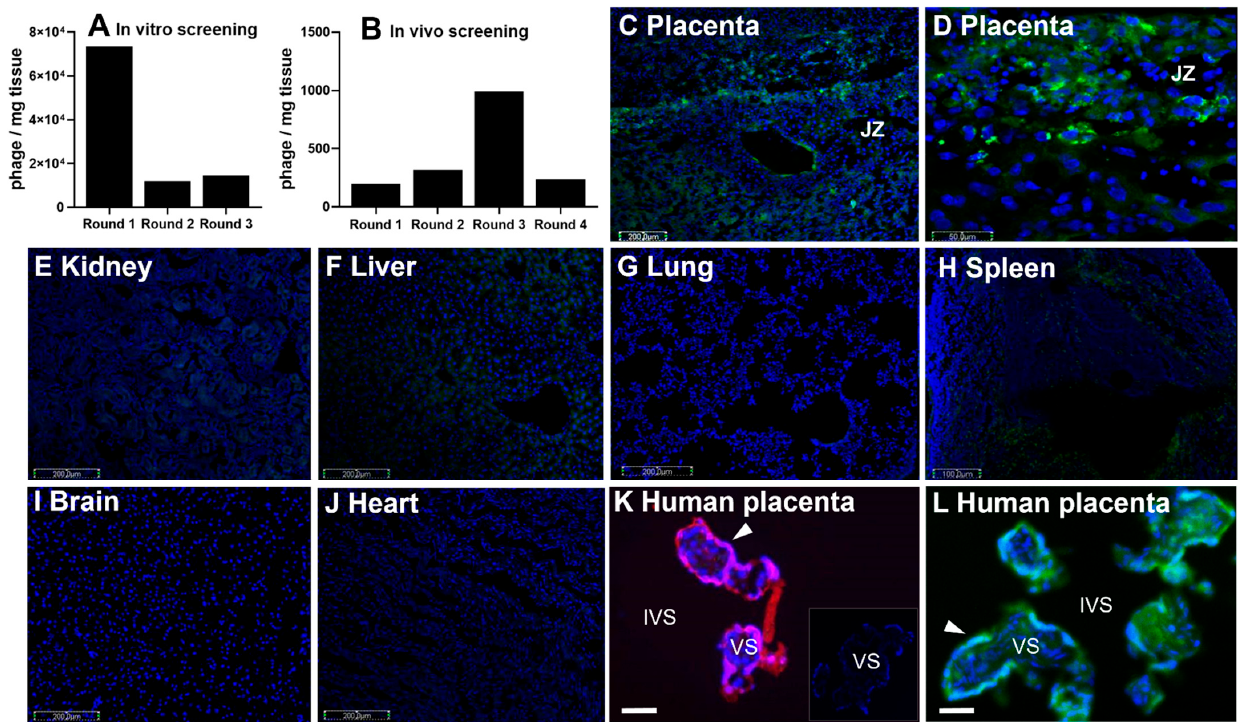
Figure 1. Identification and localization of placental-homing peptide CGPSARAPC (GPS). ( A ) Mouse placental tissue was incubated with a T7 bacteriophage CX7C library and bound phages were tittered, amplified and purified. Phage titer (pfu/mg tissue) was measured using a plaque-forming assay (median ± SEM; n = 3). ( B ) After 3 rounds of ex vivo selection, the resulting phage pool was injected into the tail vein of a pregnant mouse. Placentas were harvested and bound phage pools were tittered, amplified and purified. Four rounds of in vivo screening were performed, and phage titer is expressed as pfu/mg tissue (median ± SEM; n = 3). ( C – J ) CCGPSARAPC labeled with 5(6)-carboxyfluorescein (CFS; 200 µg) was injected into the tail vein of pregnant mice ( n = 4; E0.5 – E17.5). Following cardiac perfusion to remove unbound peptide, placentas ( C , D ) and maternal organs ( E – J ) were harvested and assessed by fluorescence microscopy. (K, L ) Human pla- cental explants were incubated with TAMRA-CCGPSARAPC (0.27 µmol/L; 3 h; n = 3) ( K ), no peptide (inset in ( K )) or liposomes decorated with CFS-CCGPSARAPC (24 h; n = 3). Peptide binding was assessed by fluorescence microscopy, and representative images are shown. CFS-labeled peptides, green; TAMRA-labeled peptides, red; DAPI (nuclei), blue. JZ = Junctional zone; VS = villous stroma; IVS = intervillous space. Arrow denotes syncytiotrophoblast. Scale bar = 50–200 µm.